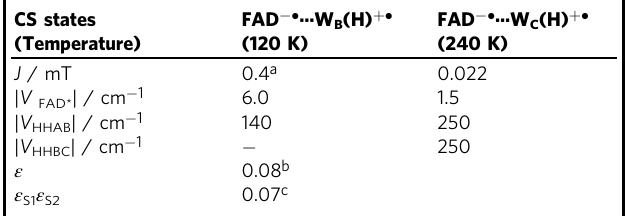
Table 1 Electronic Couplings and the Attenuation ( ε ) from the Secondary to Terminal CS